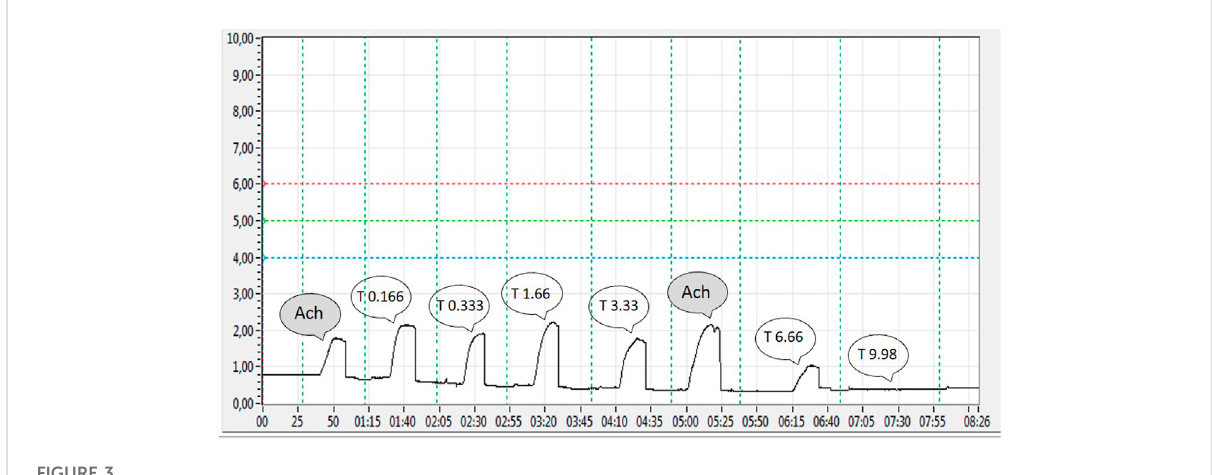
FIGURE 3 Recordings of the contraction force of a single segment of the rat ileum in the experiment to determine the dose – response relationship.Contractionoftheileumwasstimulatedwith3.6 μ MAChafterincreasingdosesofthymol(T)wereadded(0.166,0.333,1.66,3.33,6.66, 9.98